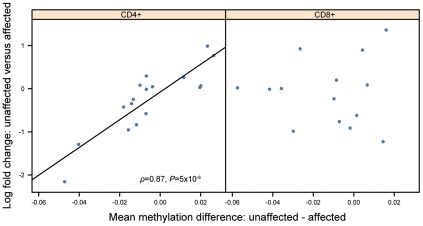
Scatter plots of differences in DNA methylation against the differences in gene expression of TNFSF11.The plots show a correlation of DNA methylation differences and gene expression differences in MZ co-twins. Each point represents a twin pair, with the mean difference in DNA methylation β-value (of 2 CpG sites) along the x-axis, and log2 fold change along the y-axis. A correlation of 0.87 was calculated in CD4+ cells.